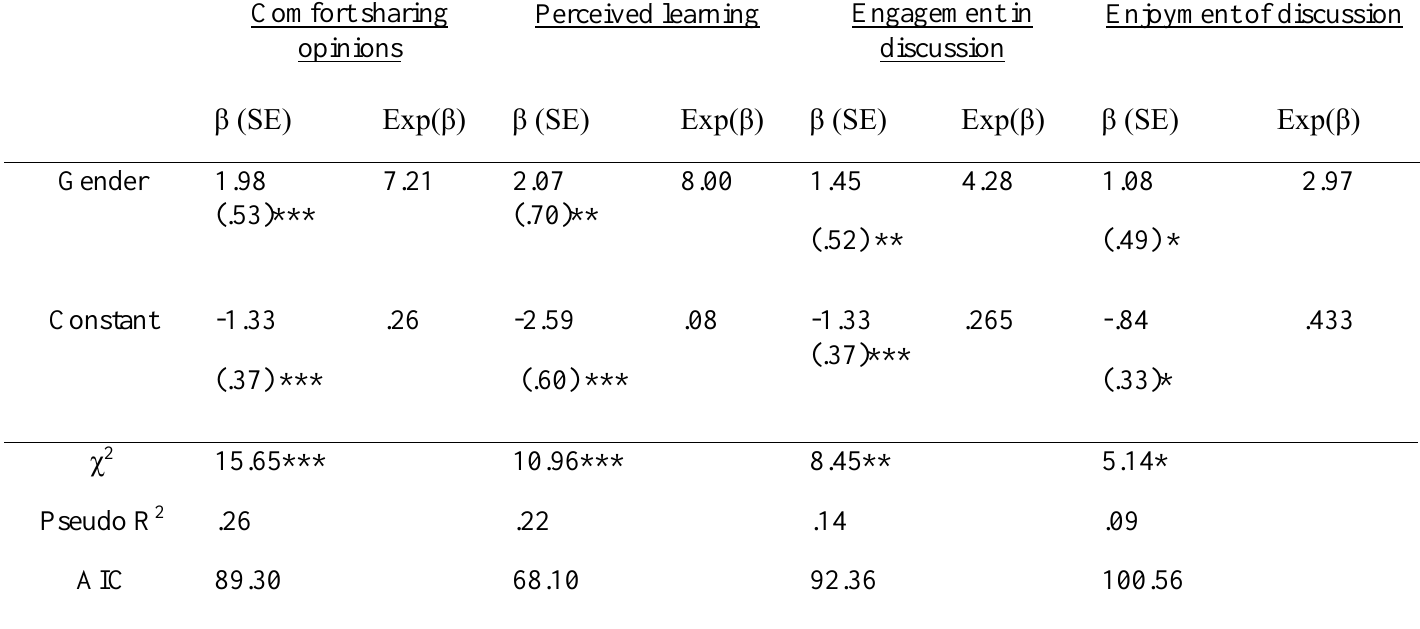
Table 6. Logistic Regression Predicting Preference for Anonymous Discussion Environment Comfort